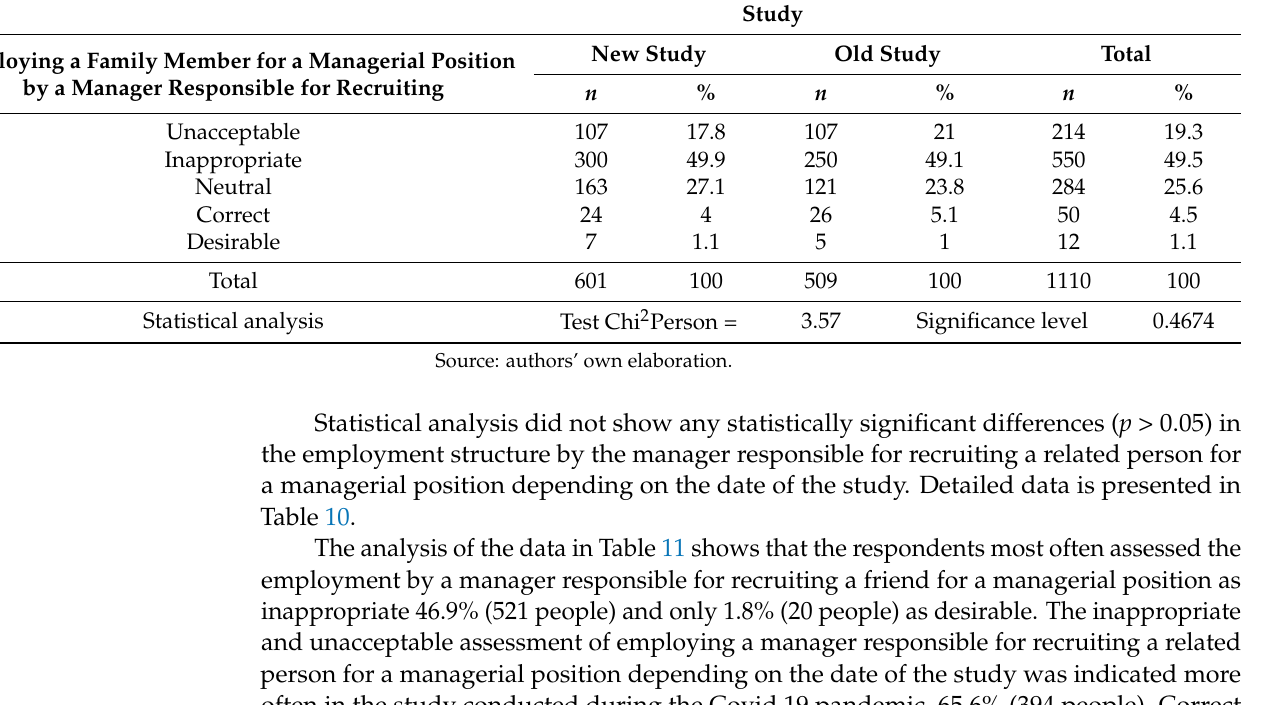
Table 10. Statistical analysis of assessment of employing a relative for a managerial position by a manager responsible for recruiting depending on the date of the survey.